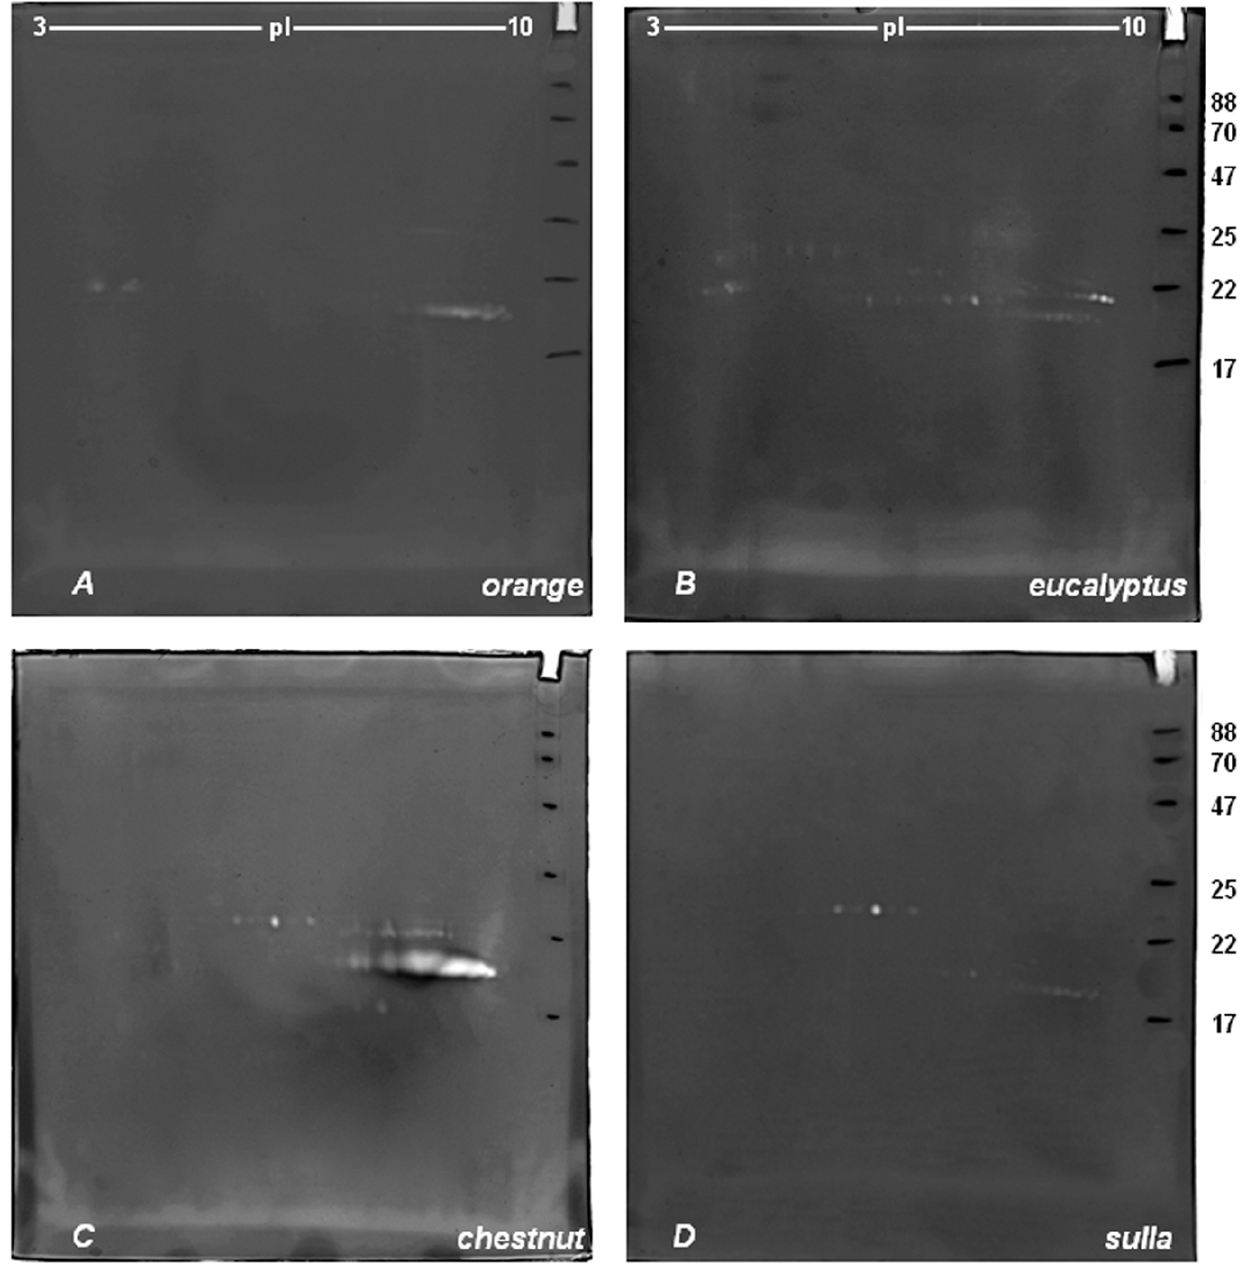
Figure 2. 2-D zymography (2-DZ) of the proteolytic activities present in honey MT2 extracts. Proteolytic activities were detected by 2-D zymography on gels copolymerized with gelatin. Gels: A ( orange honey), B ( eucalyptus honey), C ( chestnut honey) and D ( sulla honey). 80 m g of proteins were applied to each gel.